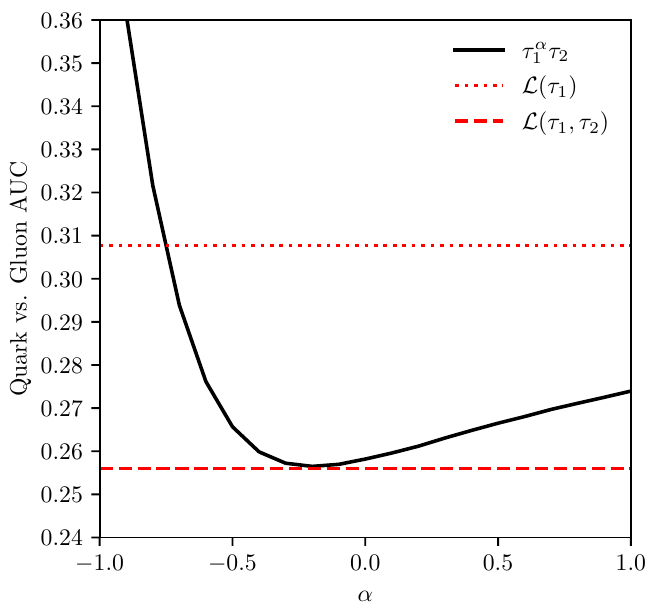
= (cid:28) (cid:11) (cid:28) 2 . The AUC of the 1 O